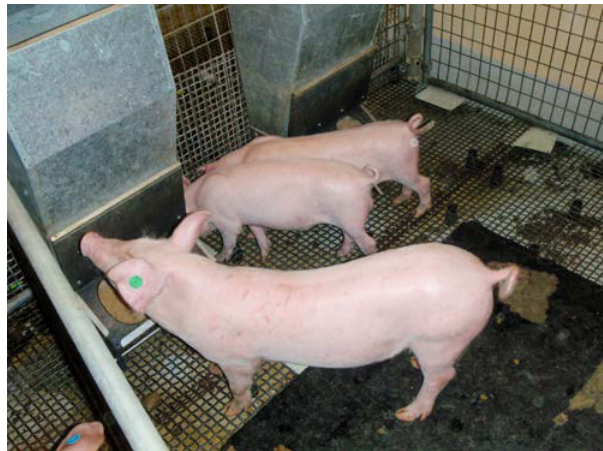
Figure 2. Littermates from litter 8 in D55 at 77 days old—note the stunting of two chronically infected littermates (8-01 and 8-05) compared with the larger non-persistently or chronically infected animal (8-03).